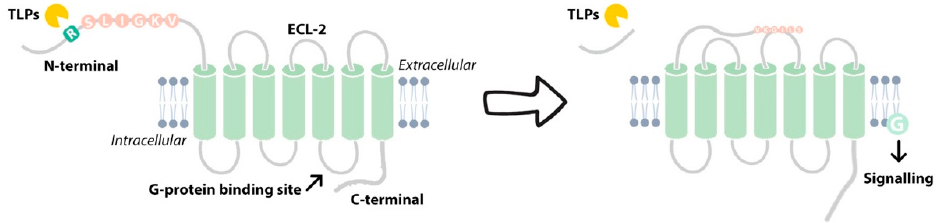
Figure 4. Proteolytic processing of the N-terminus of PAR2 at Arg 36 by TLPs generates a tethered ligand (SLIGKV) that triggers intracellular G-protein signalling through binding to the extracellular loop 2 (ECL-2).